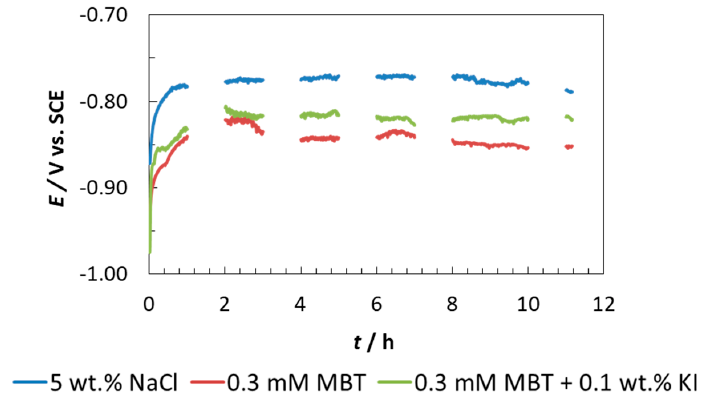
Figure 3. The influence of the immersion time on the open circuit potential values of the AA6082 aluminium alloy samples immersed in 5 wt.% NaCl solution with and without 0.3 mM MBT or a combination of 0.3 mM MBT and 0.1 wt.% KI at 25 °C. The discontinuous parts of the curves indicate the moments when the EIS measurements were performed.